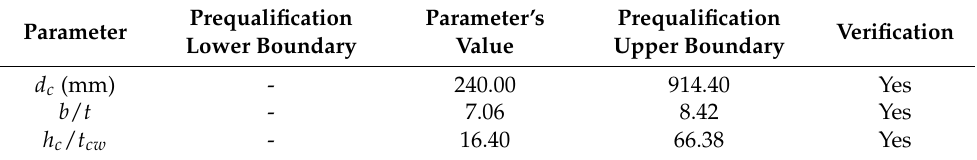
Table 2. Column characteristics vs. prequalification limits.